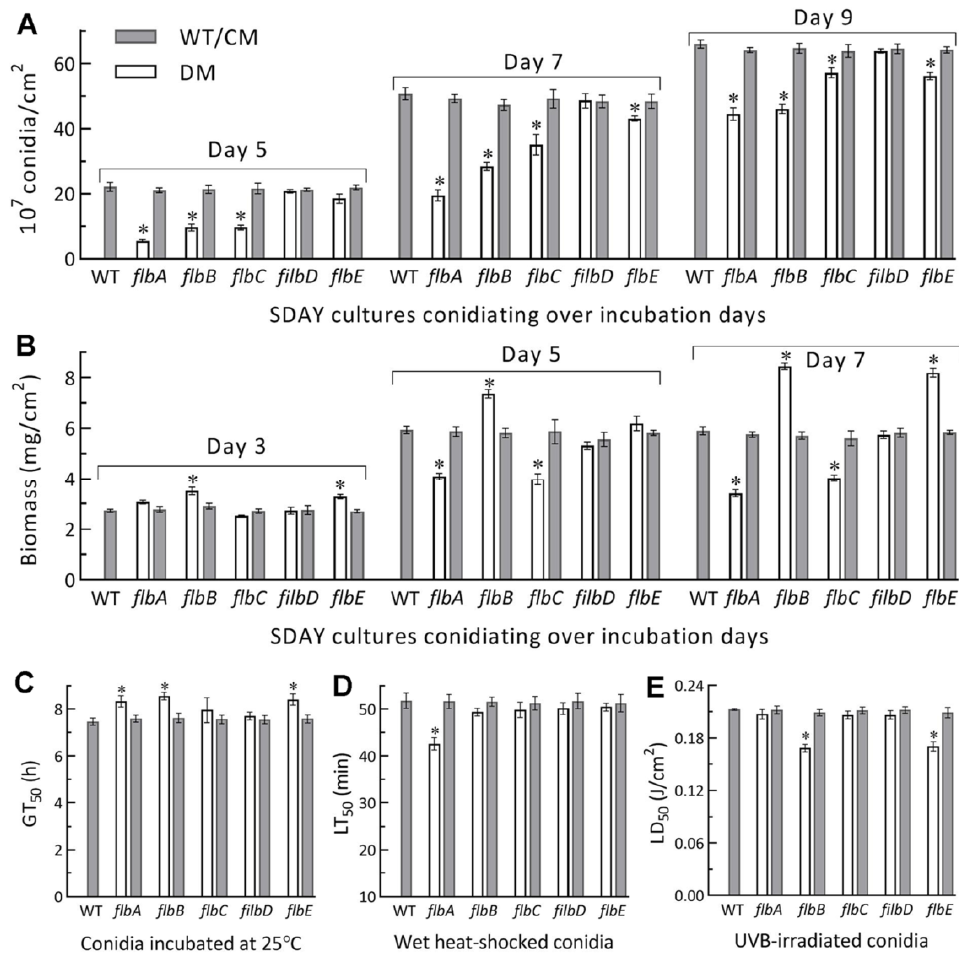
Figure 3. Aerial conidiation and conidial quality of Δ flb mutants (DM) and their control (WT and CM) strains in B. bassiana . ( A , B ) Conidial yields and biomass levels measured from the SDAY cultures during a 9-d incubation at the optimal regime of 25 ° C and L:D 12:12, respectively. The cultures were initiated by spreading 100 μ L aliquots of a 10 7 conidia/mL suspension. ( C – E ) Median germination time GT 50 (h) for conidial viability at 25 ° C, LT 50 (min) for conidial tolerance to a 45 ° C wet–heat stress and LD 50 (J/cm 2 ) for conidial resistance to UVB irradiation, respectively. * p < 0.05 in Tukey’s HSD tests. Error bars: SDs of the means from three independent replicates .